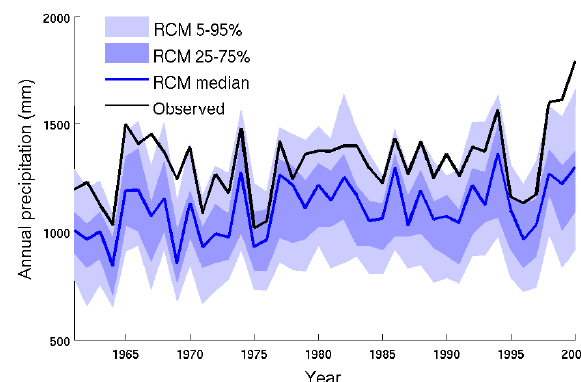
Fig. 2. Mean annual precipitation accumulated at the station in Montford catchment for the 18 RCMs over the study period 1961– 2000. The 5–95 percentiles are shown in light blue, and the dark blue denotes the 25–75 percentiles. The solid black line shows the observed precipitation from the UK MetOffice.